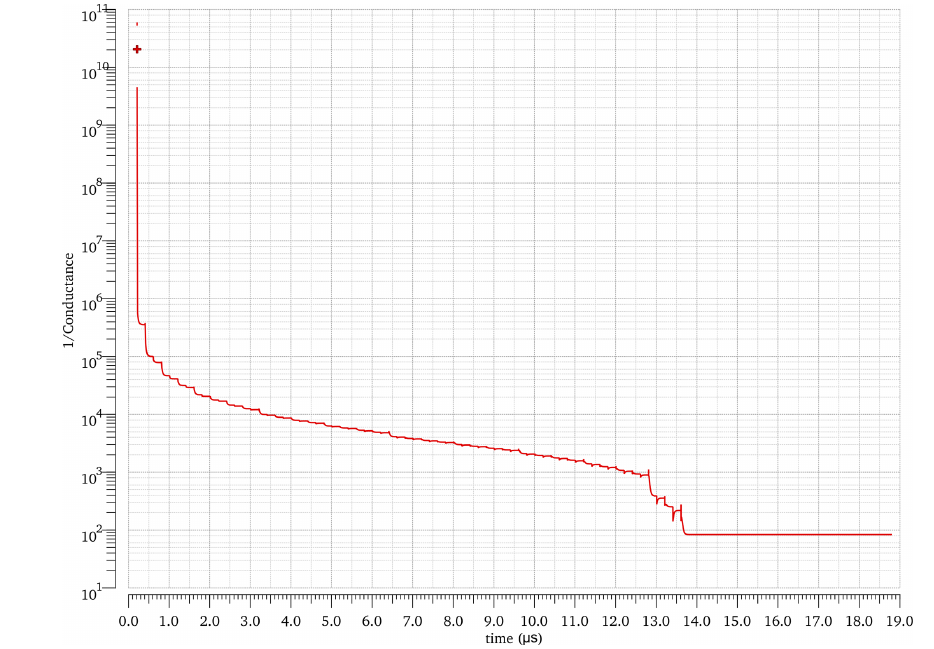
Figure 25. This graph shows the error between the desired and the actual value of the first synapse of the first ACD. The variables V LEAK , V RFR , vg1, and vg2 of the second layer are fixed to 700mV, 800mV, 1.8V, and 220mV, respectively. Circuit conditions are V dd of 3 . 3V, and temperature equals 27 ◦ C and on the nominal process.